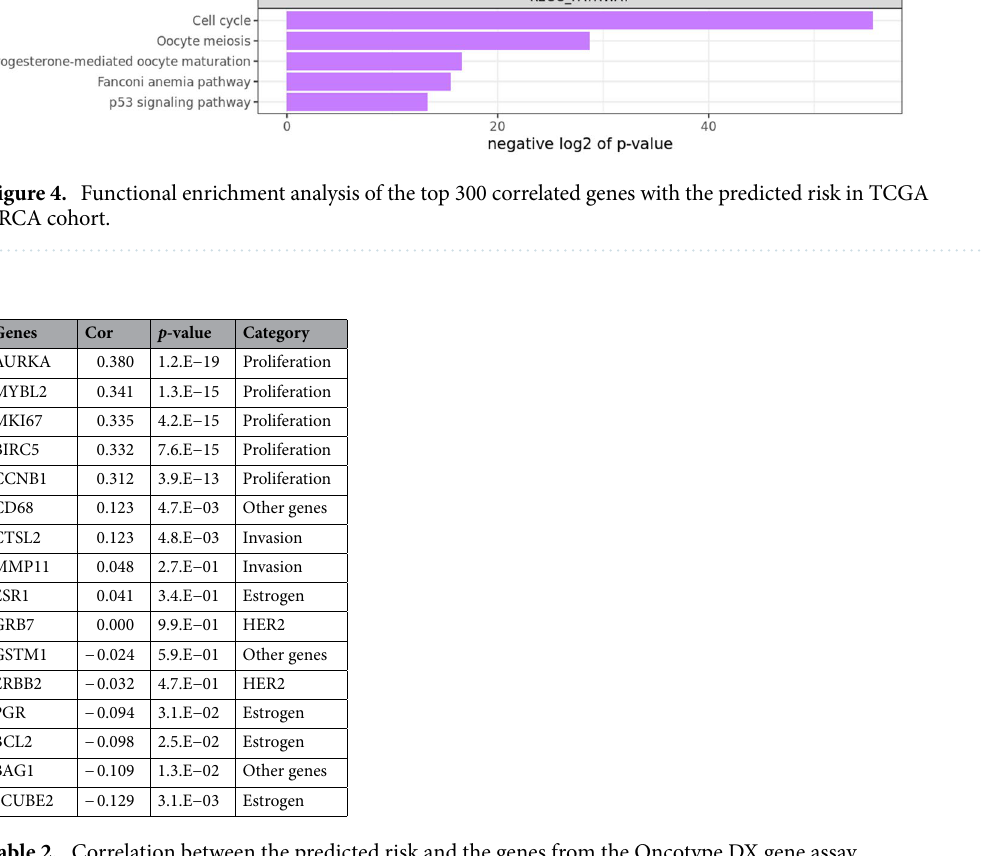
Table 2. Correlation between the predicted risk and the genes from the Oncotype DX gene assay.